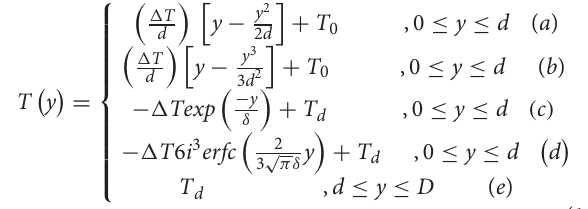
Frontiers in Mechanical Engineering |